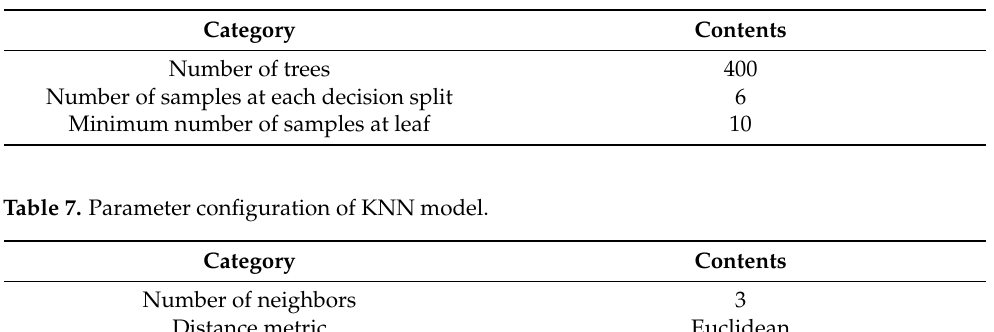
Table 6. Parameter configuration of RF model.